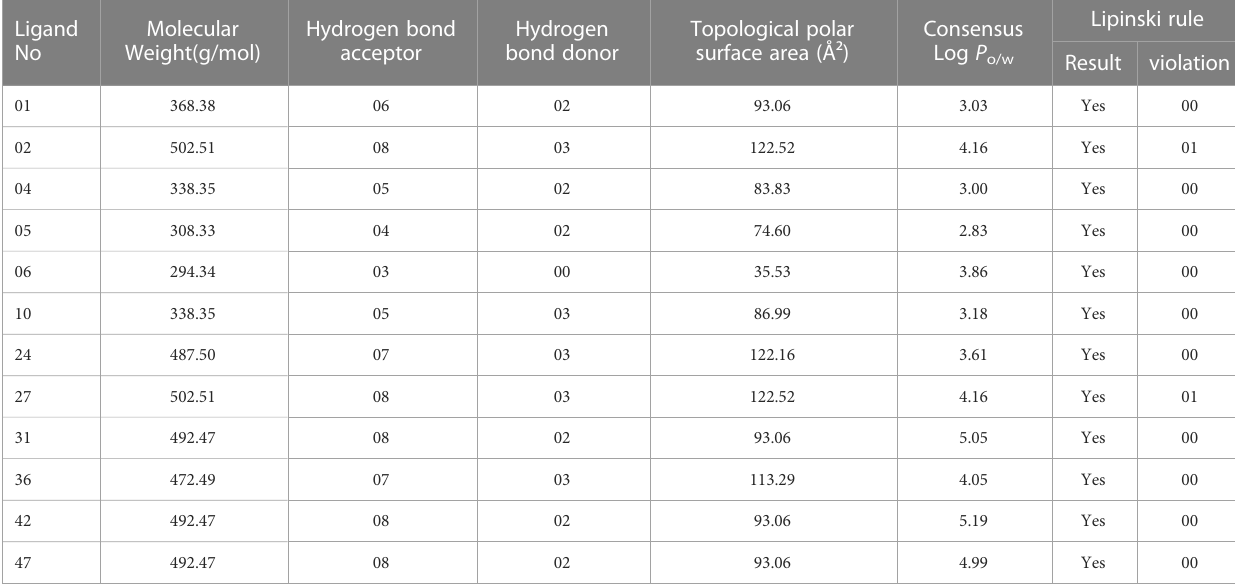
TABLE 2 Predicted data of Lipinski rule,